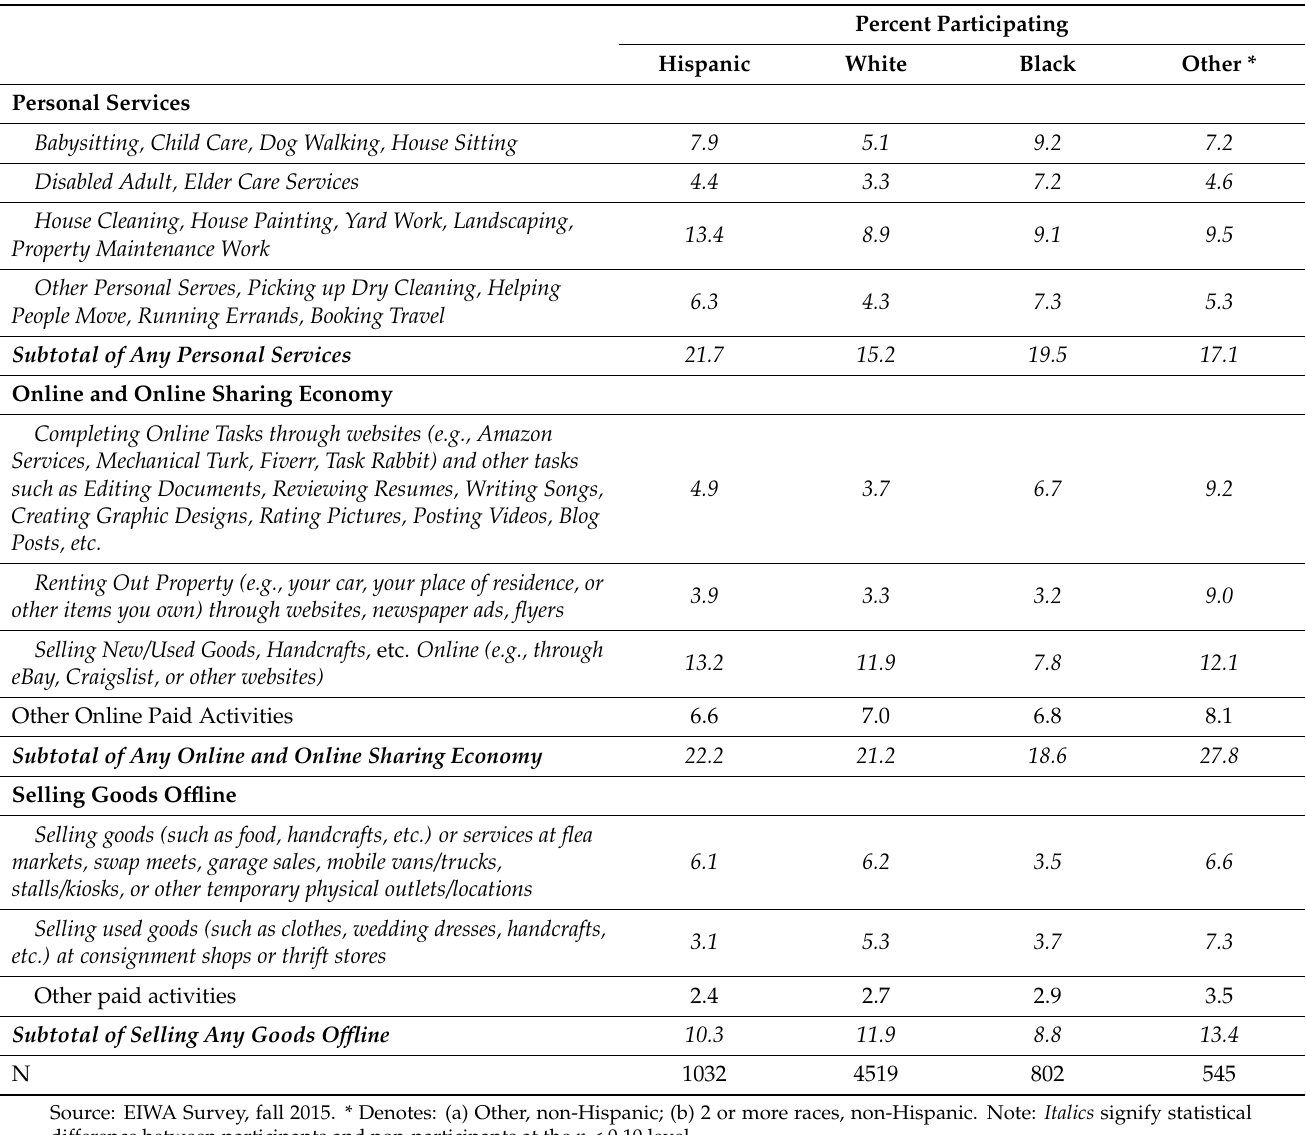
Table 4. EIWA by Category for Hispanics and Other Racial/Ethnic Groups. Percent Participating Hispanic White Black Other